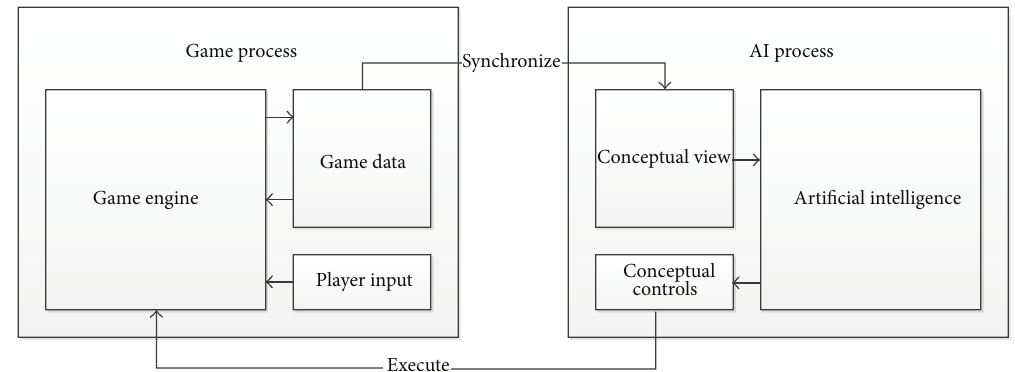
Figure 12: Running AI in a separate process. Synchronizing a conceptual view with game data requires an inter-process communication mechanism such as sockets or remote procedure call (RPC) systems. The mechanism is also required for using conceptual controls.